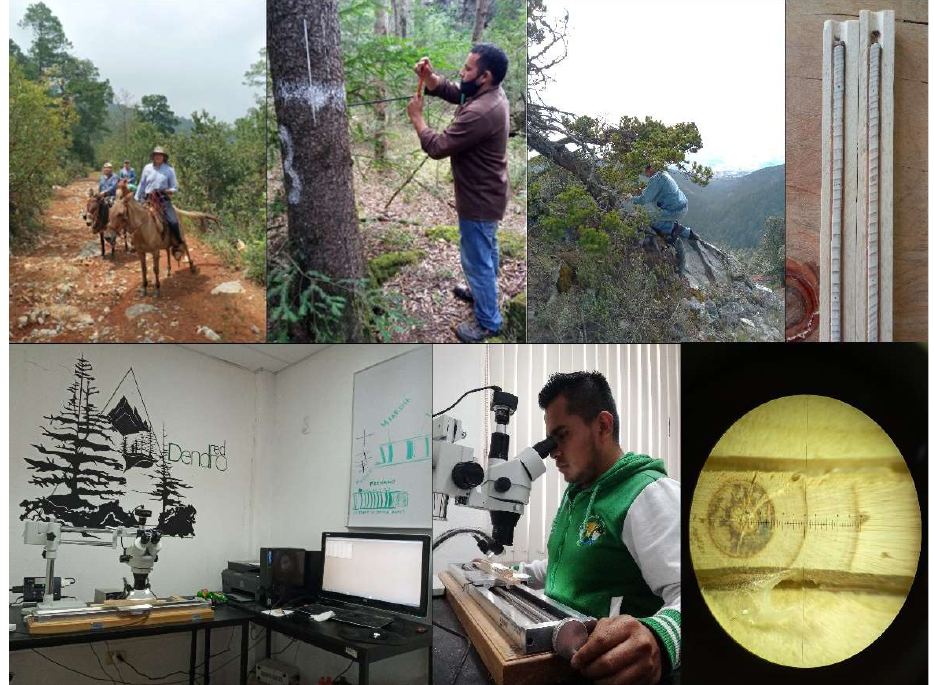
Figure 2. Gathering and processing dendroecological